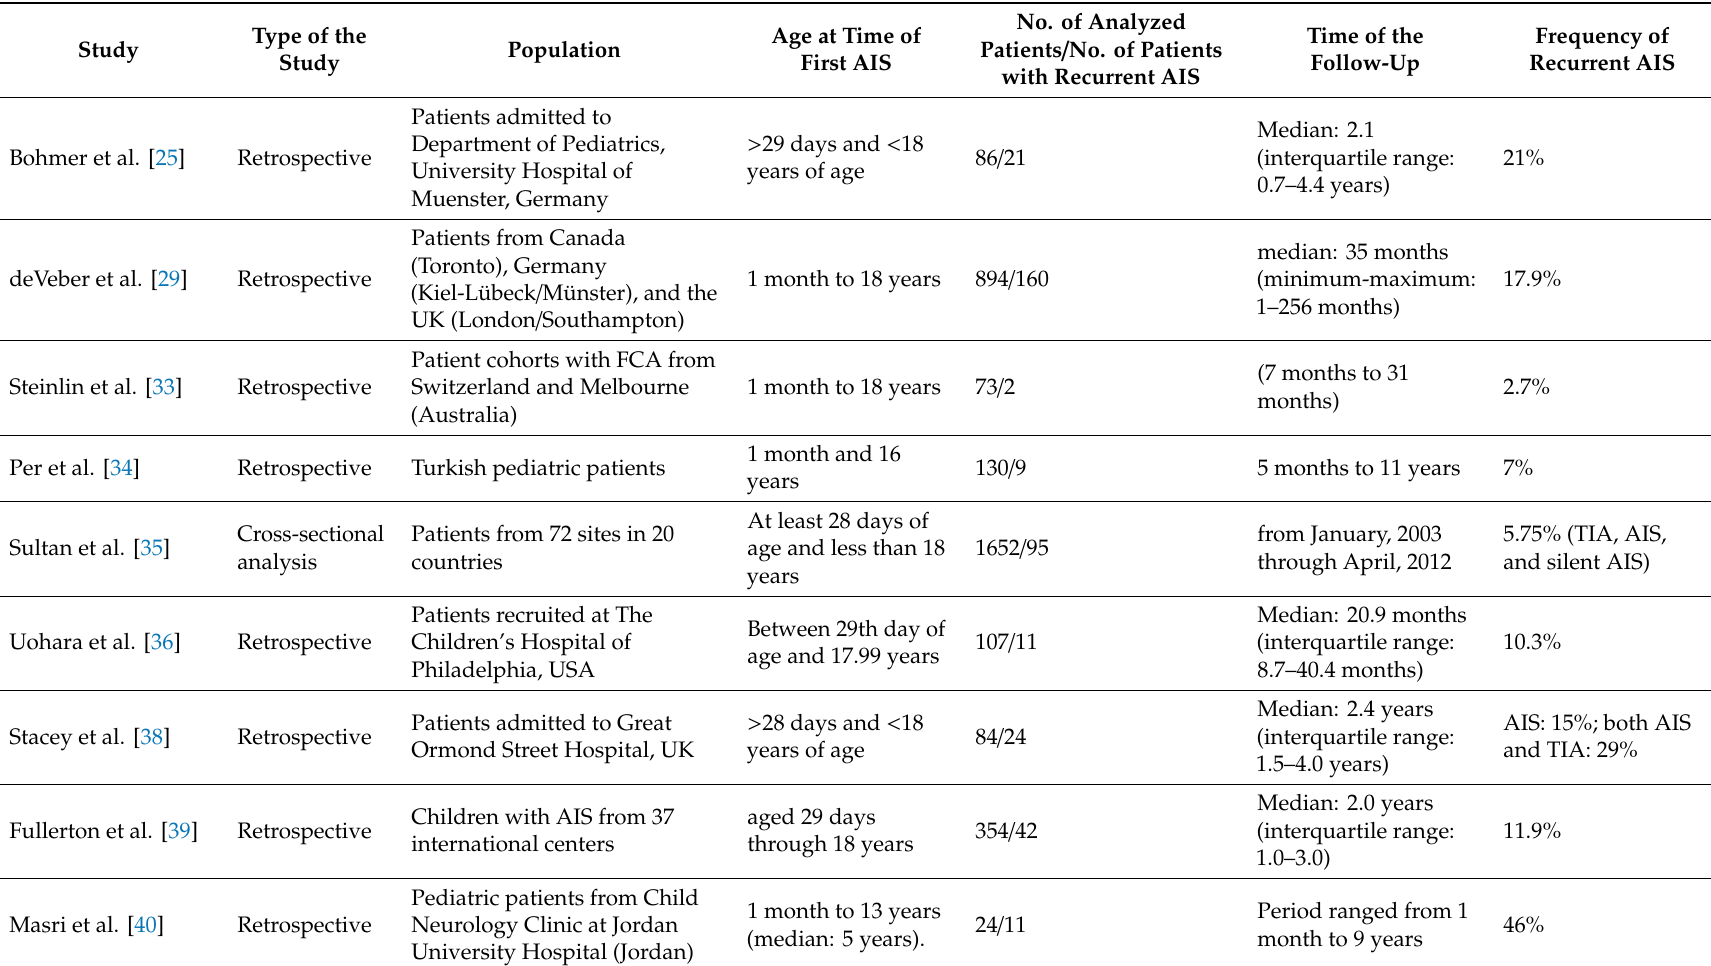
Table 1. Prevalence of arterial ischemic stroke (AIS) recurrence in di ff erent pediatric